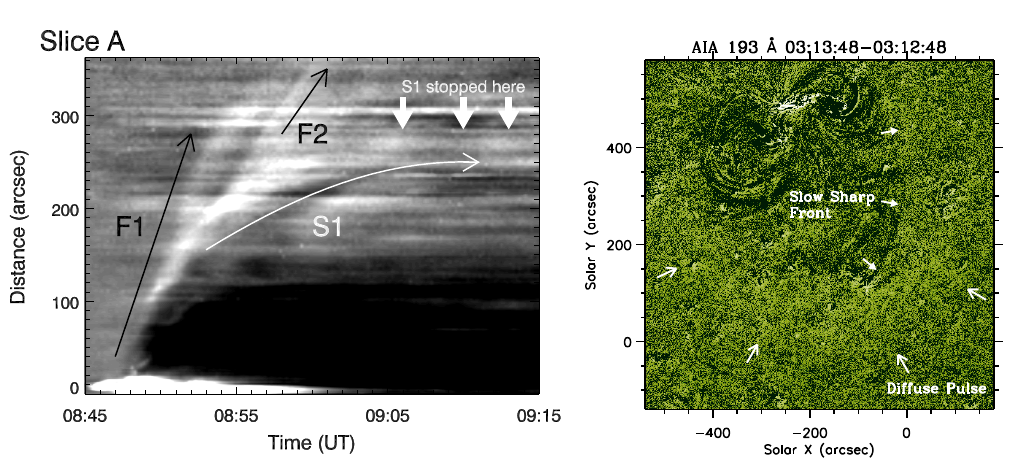
Figure 21: Multiple wavefronts in coronal wave events seen with SDO/AIA. Left : Distance-time intensity stack plot at 193 ˚ A of the coronal wave of 2010 Jul 27. Two fast waves (F1 and F2) and a slower trailing disturbance (S1) can be seen. Right : Difference image at 193 ˚A showing multiple wavefronts (a fast diffuse pulse and several sharp fronts) in the coronal wave of 2010 Apr 8. Images reproduced with permission from [left] Chen and Wu (2011) and [right] Liu et al. (2010), copyright by